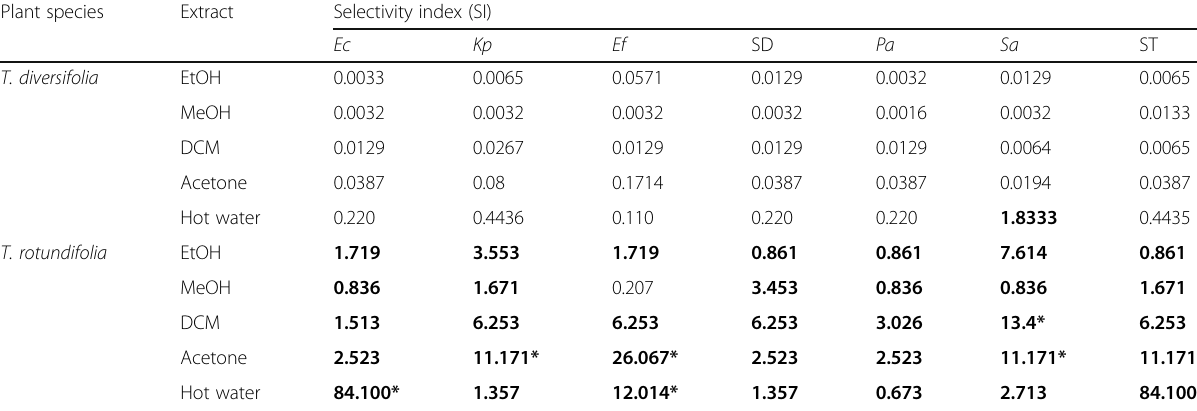
Table 6 Selectivity index of bacterial strains tested against T . diversifolia and T . rotundifolia solvent extracts Plant species Extract